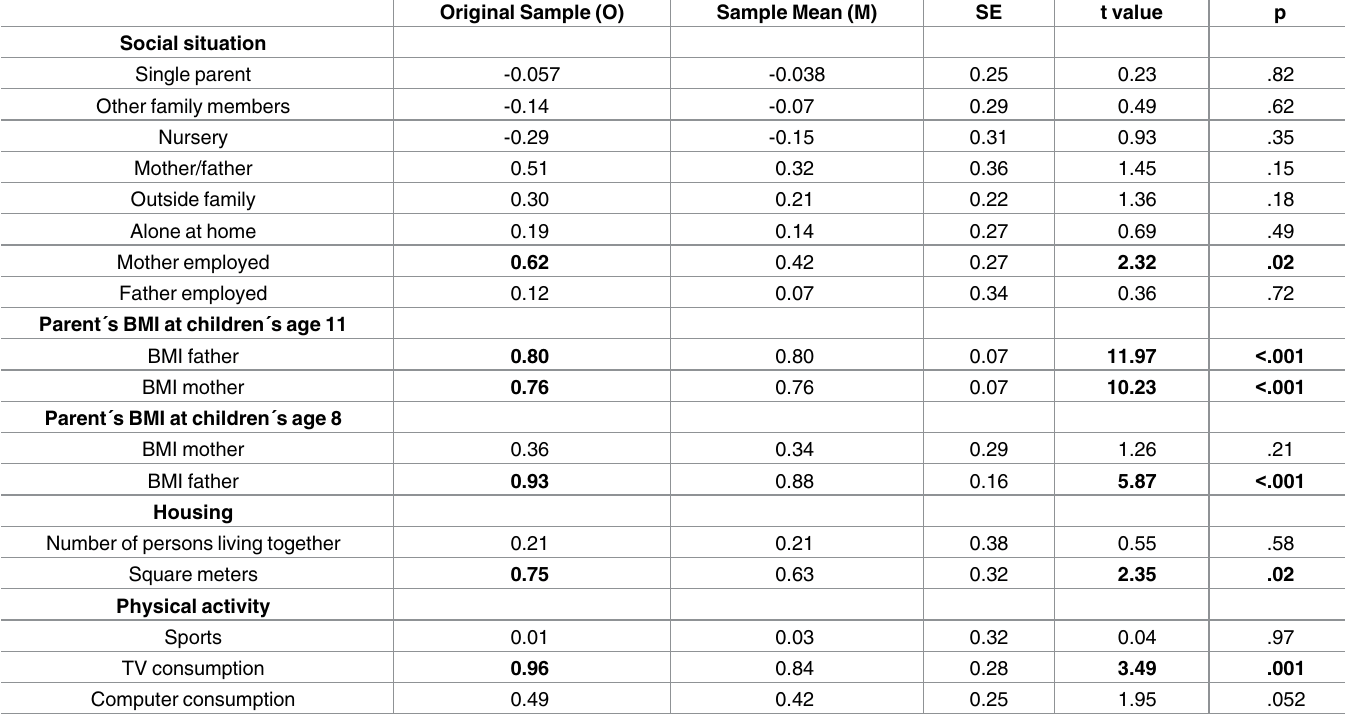
Table 4. Outer (factor) loadings of variables on their latent constructs. Significant t values after bootstrapping are printed in